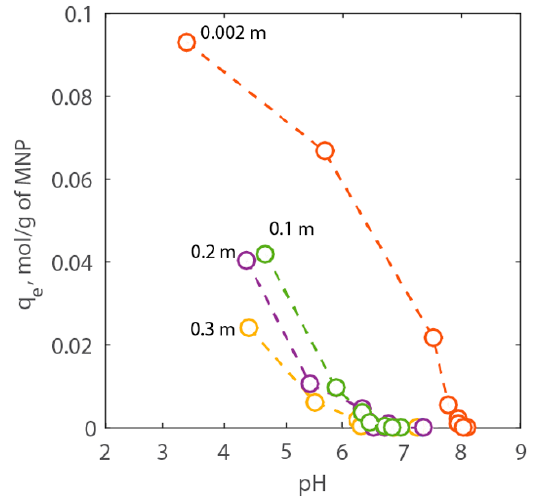
Figure 6. Titration results expressed as adsorption capacity of H + vs. pH for NaCl concentration between 0.01 to 3.00 wt % corresponding to 0.002 to 0.3 m, respectively.